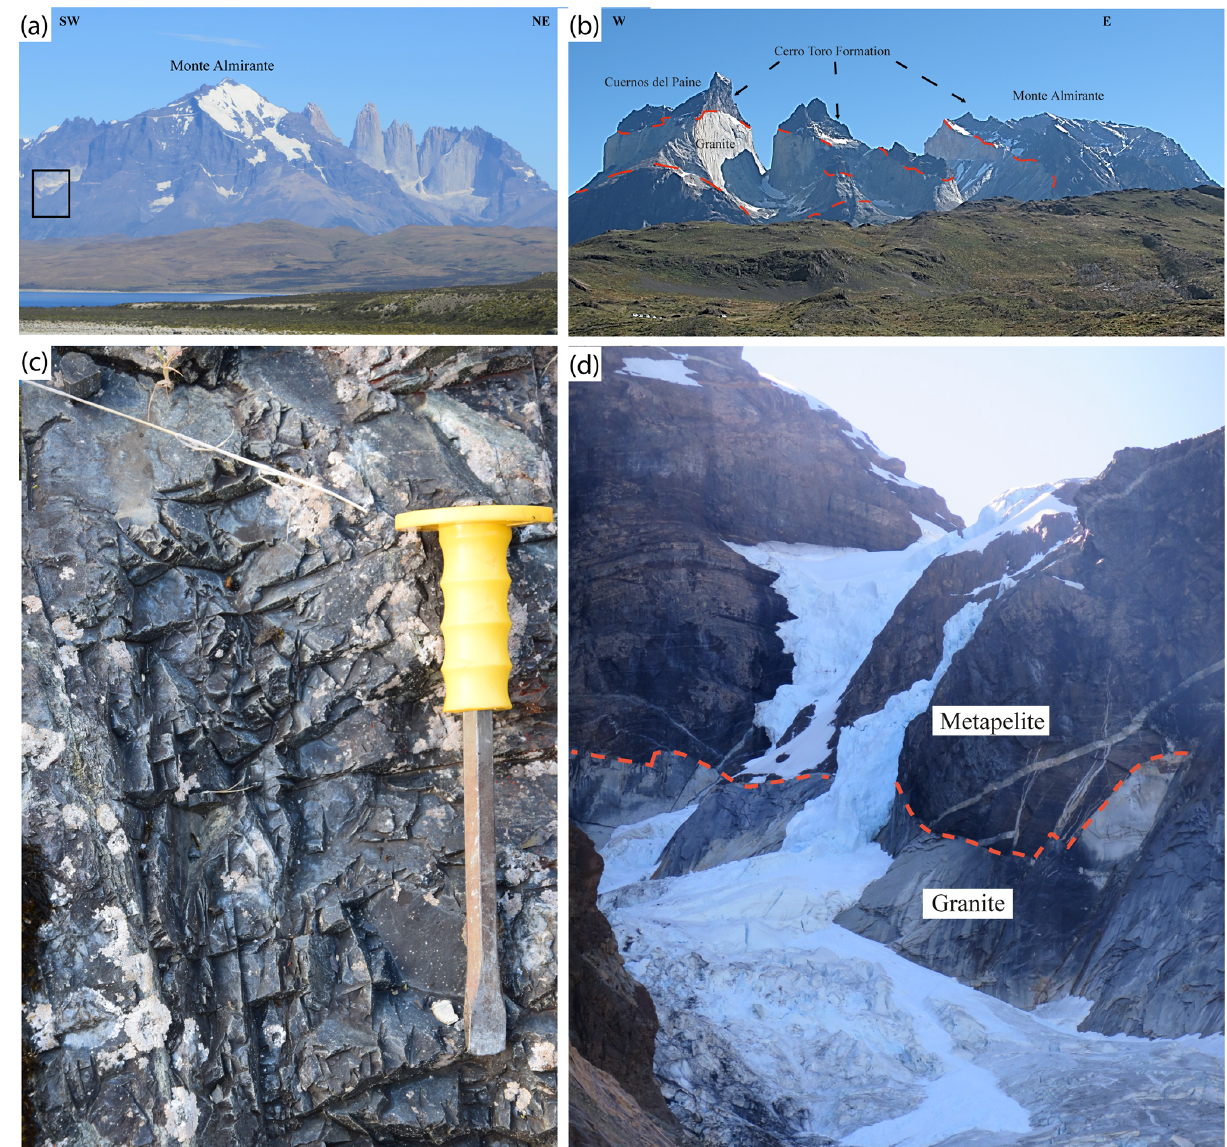
Figure 2. (a) View of the Torres del Paine intrusive complex from the eastern park entrance in the Última Esperanza district. The black rectangle indicates the location of panel (d) . (b) Well-exposed Torres del Paine sill which is overlain by the Upper Cretaceous Cerro Toro Formation. The contact between the granite and adjacent metapelite is indicated by the dashed red line. (c) Contact metamorphic hornfels ca. 50m from the intrusion. Chisel length is ca. 30cm. (d) Contact between granite and metapelite at the Monte Almirante